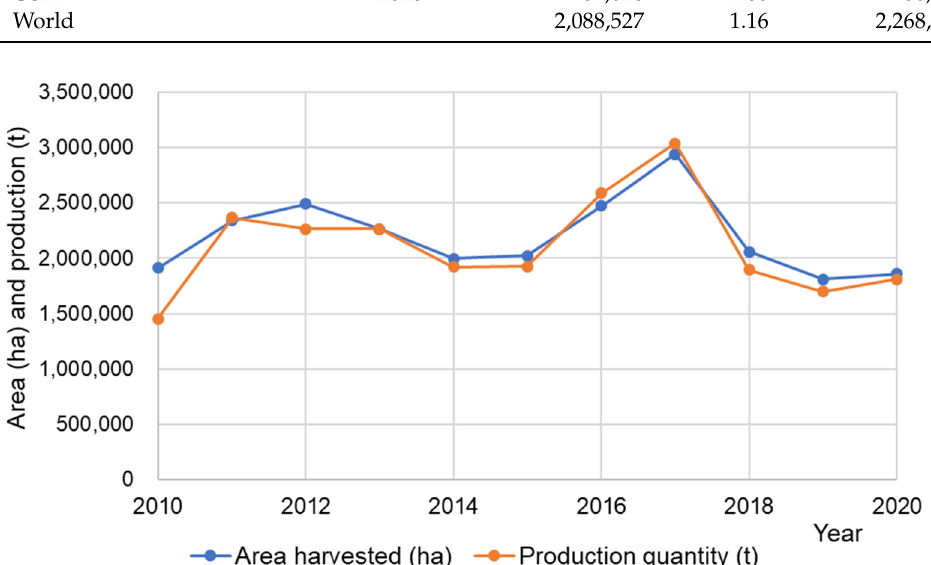
Figure 4. Area harvested (ha) and buckwheat ( Fagopyrum spp.) production quantity (t) in the world in the last ten years [18].